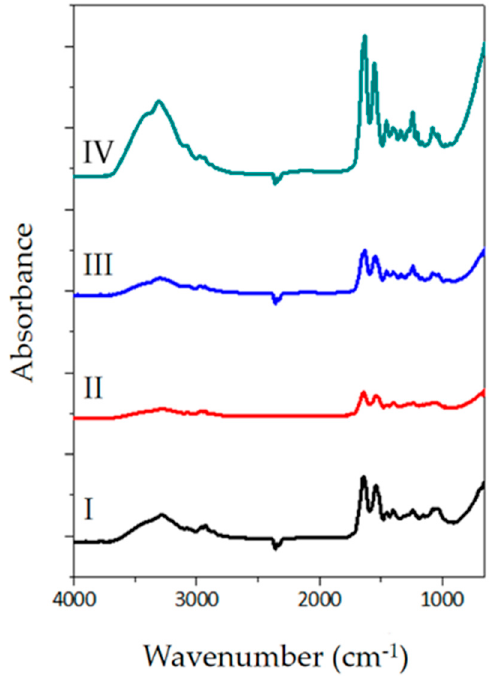
Figure 8. FTIR spectra for DM obtained from the four protocols.